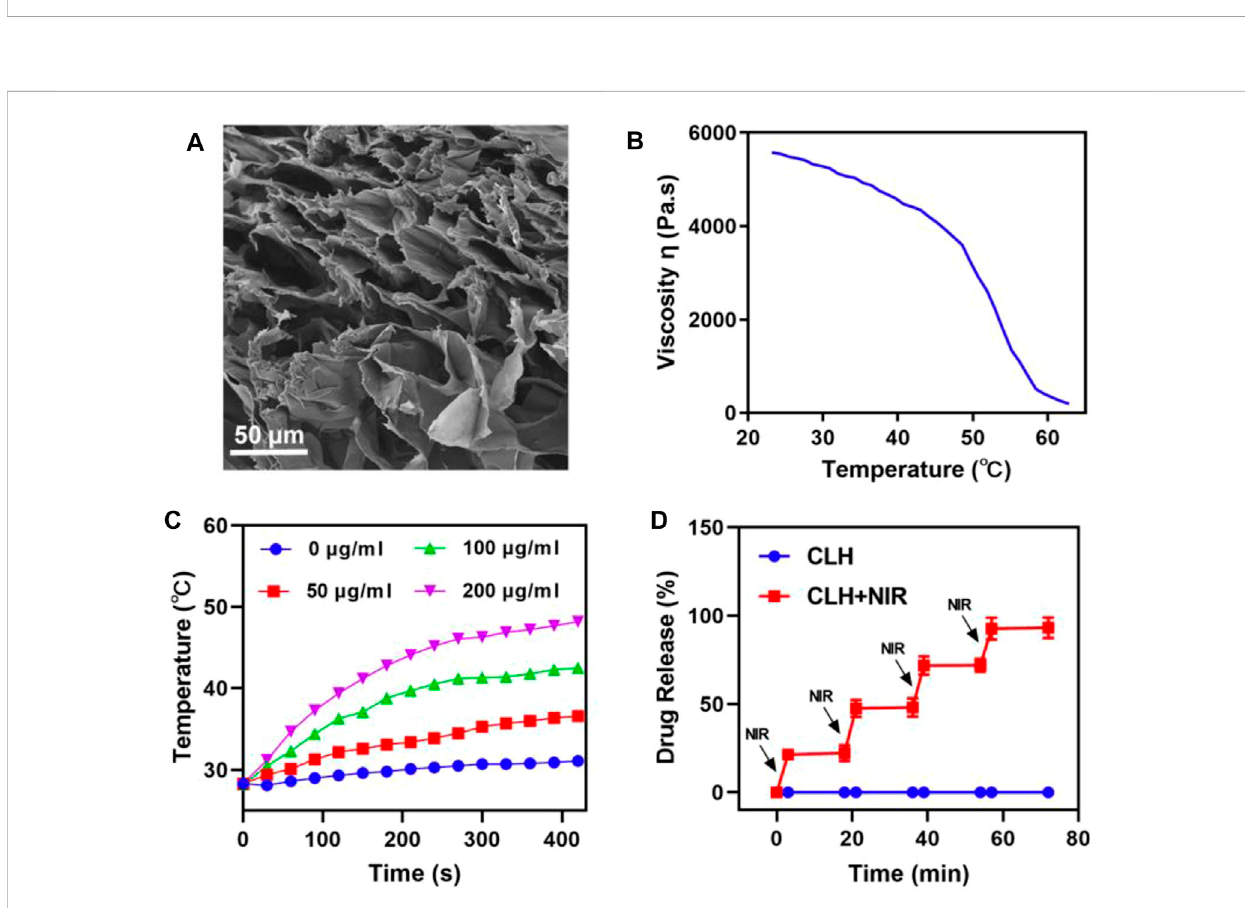
FIGURE 2 (A) Representative SEM images of CLH. (B) Viscosity measurements of reversibility for CLH during temperature jumps, from 23.17 ° C to 62.82 ° C. (C) Heating curves of varying CLH doses upon 808 nm laser at 0.5 W/cm 2 . (D) The CLH release pro fi le, with or without 808 nm laser irradiation, with black arrows indicating irradiation time